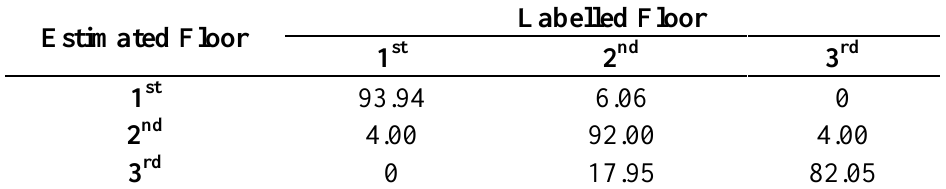
Table 7. Confusion matrix for floor detection using ML wireless positioning (Unit: %).